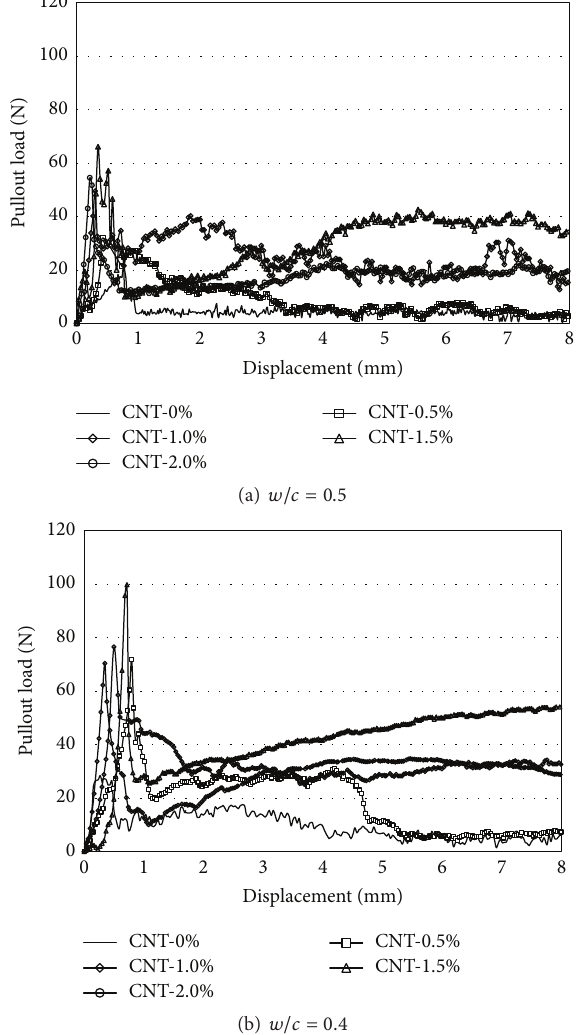
Figure 4: Pullout behavior of macrosynthetic fiber in